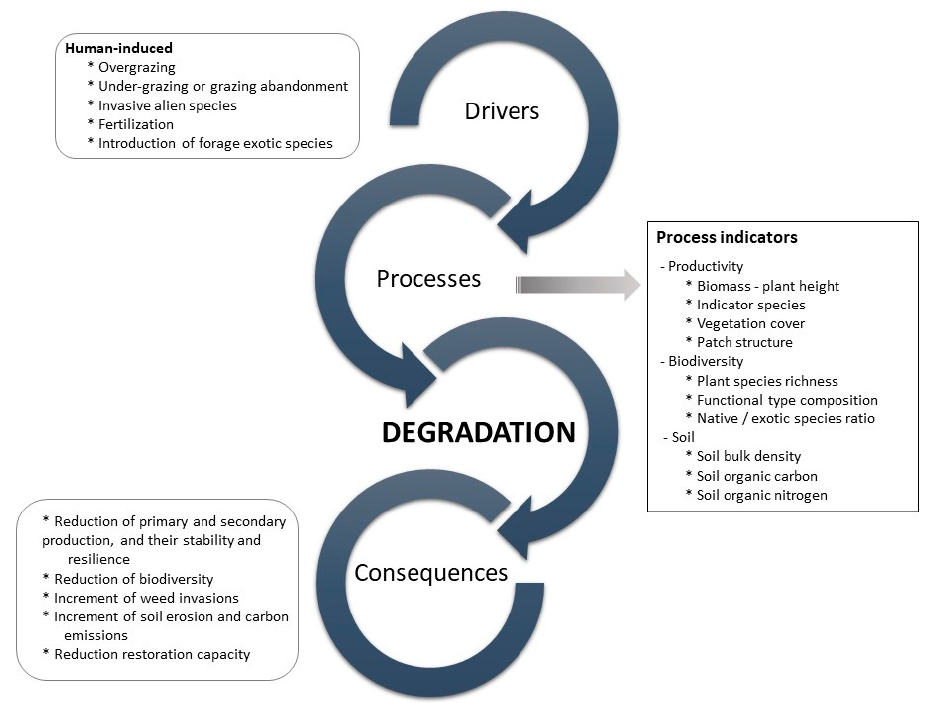
Figure 3. Proposed conceptual framework of RPG degradation with drivers, process indicators, and consequences based on literature review and expert survey.